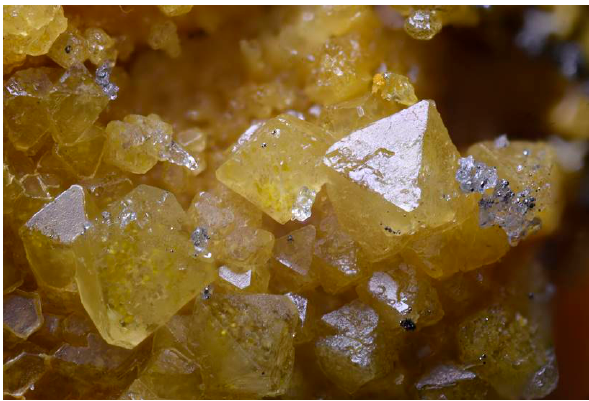
Figure 3. Alum-(K) from the Monte Arsiccio mine, as yellowish octahedra up to 2 mm in size.